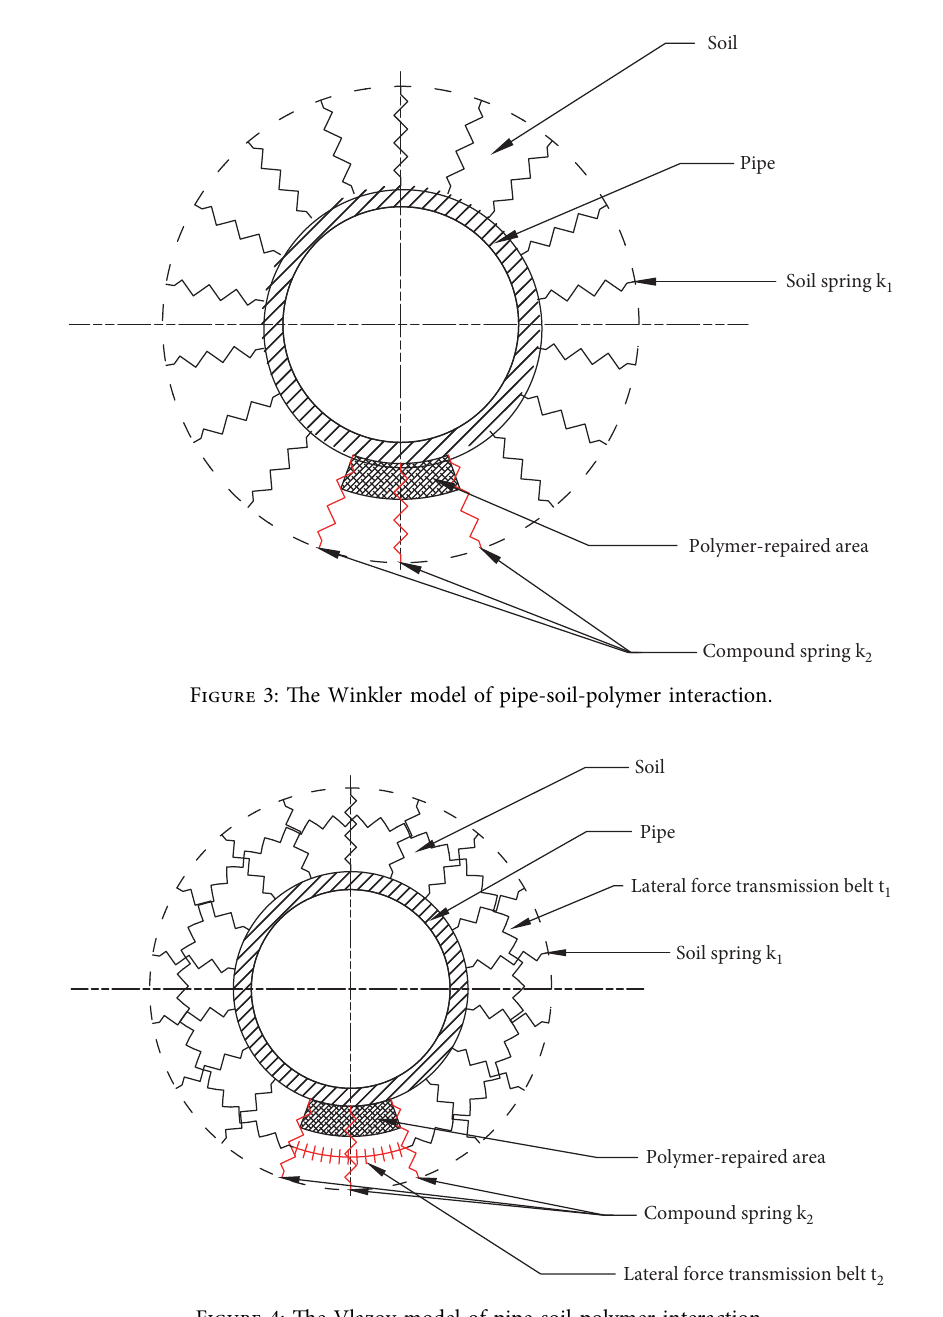
Figure 4: The Vlazov model of pipe-soil-polymer interaction.